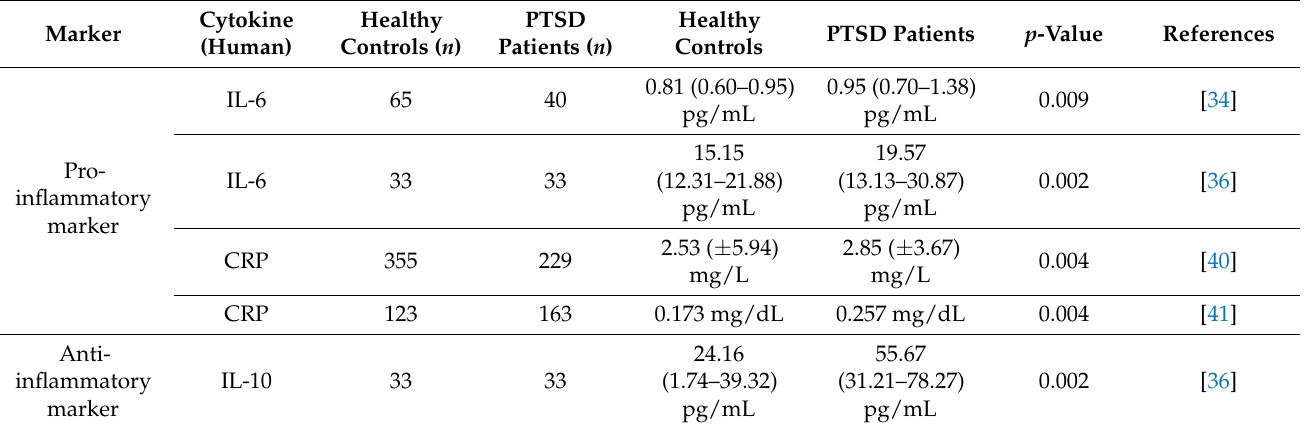
Table 1. Comparison of pro-inflammatory and anti-inflammatory markers between healthy controls and PTSD